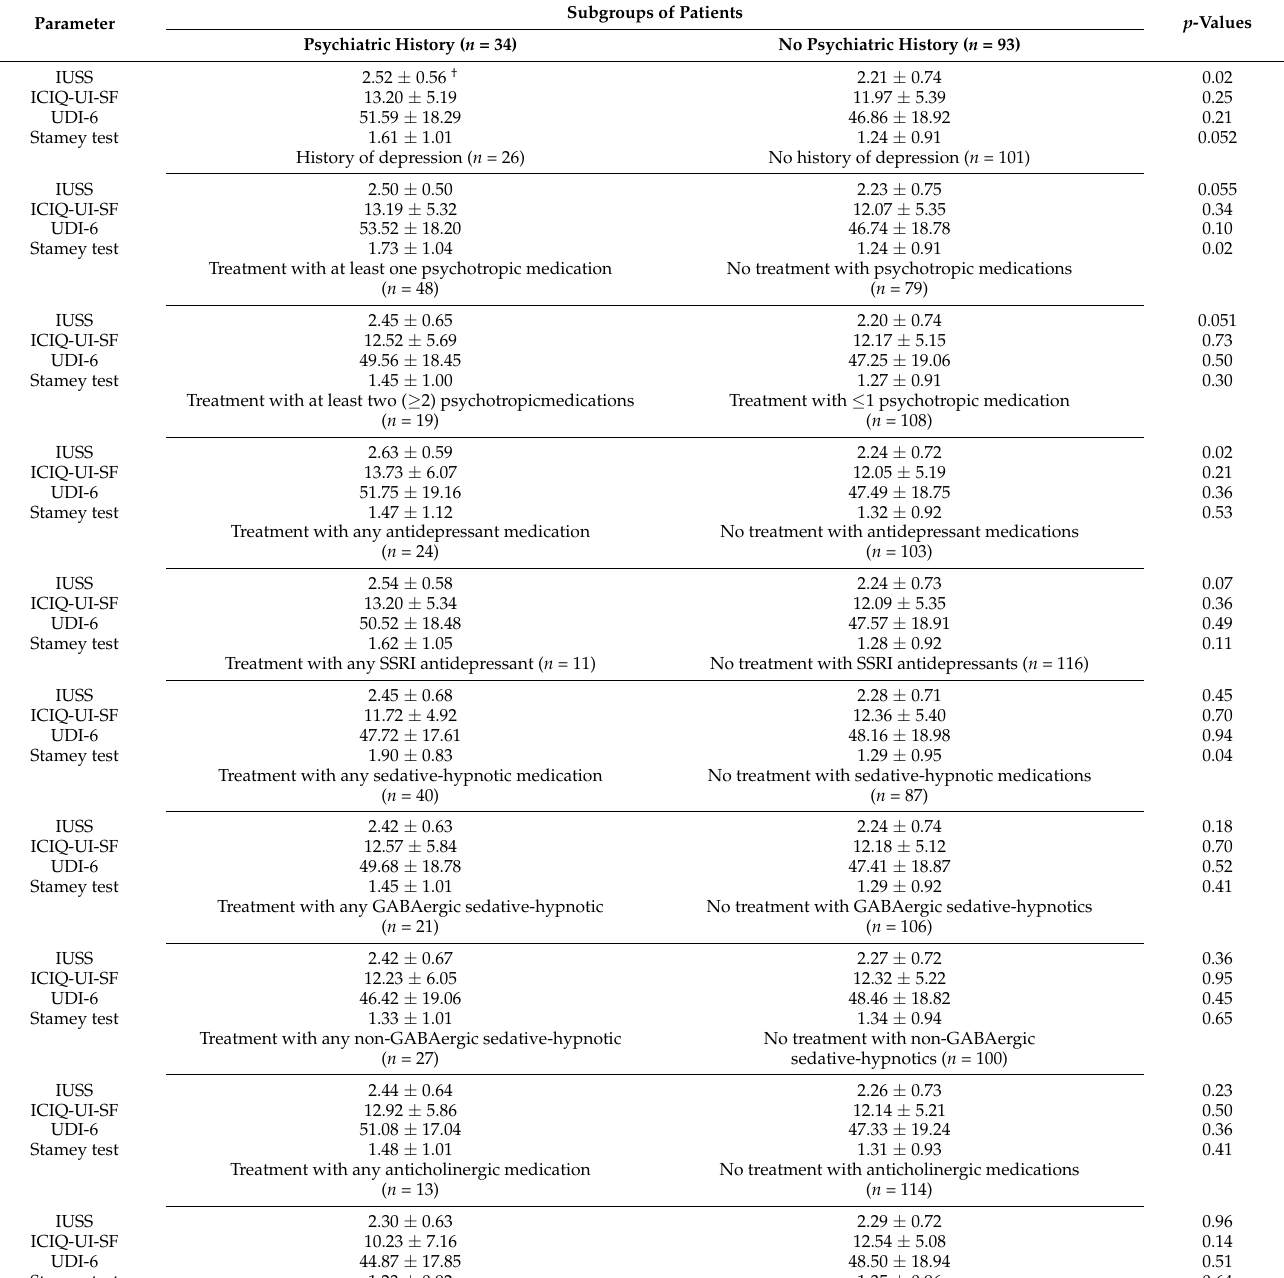
Table 2. Psychiatric history, psychotropic medications currently taken and severity of OAB and incontinence symptoms.